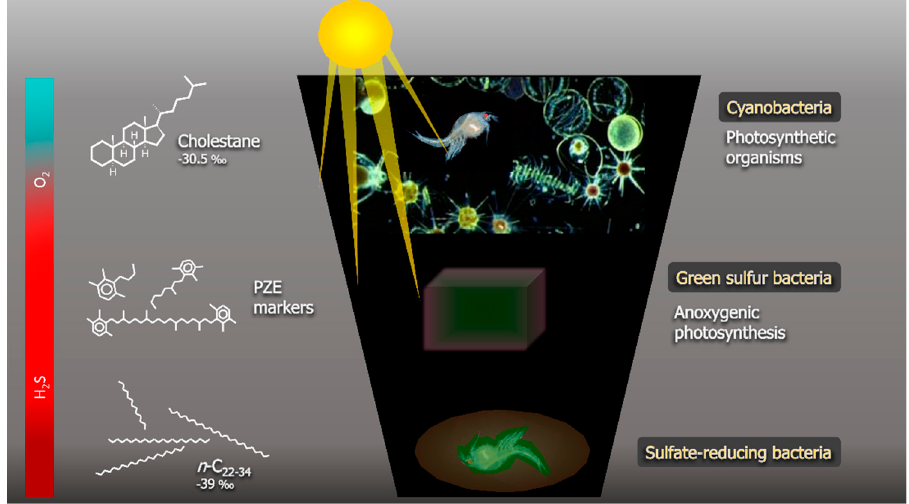
Figure 3. The preservation mechanism of a fossilised crustacean inside a carbonate concretion, as described by Melendez et al . [10].